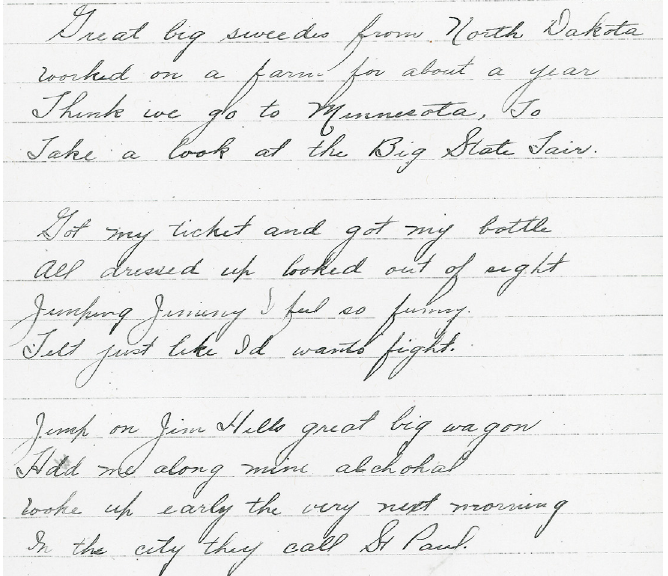
Figure 3: Beginning verses of the “Swede from North Dakota” hand-written in Ludwig Rydquist’s 1910 notebook. (Photo: James P.